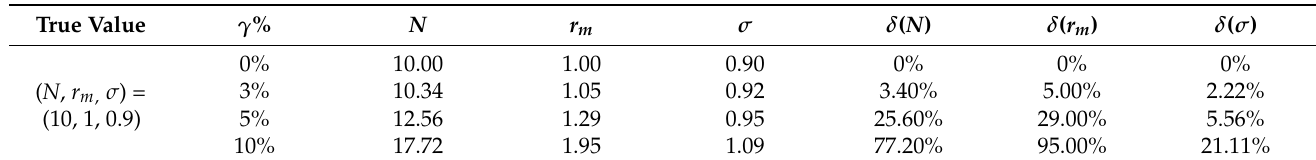
Table 4. The relative error under different random errors.